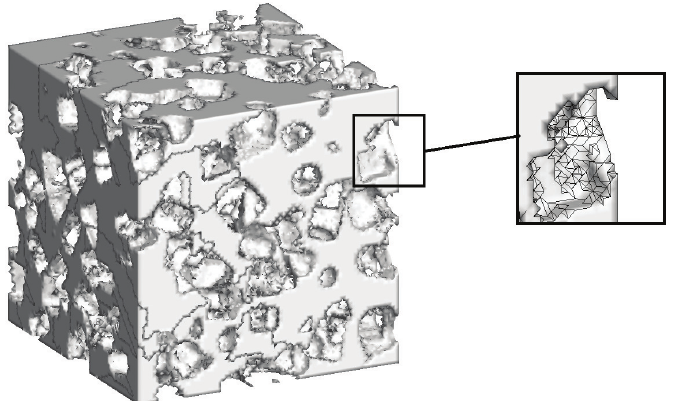
Figure 6. A porous microstructure generated with the developed method containing pores of different shapes and sizes with the Partially overlapping selection (POS) distribution mode.